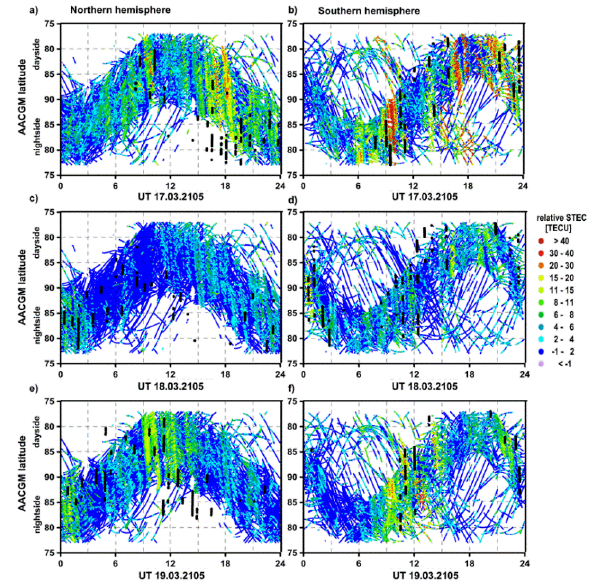
Figure 4. The comparison of patch detection using GNSS-based relative STEC values and SWARM in situ data (black dots). AACGM latitudes are derived with the projection of measurement points onto the noon – midnight axis of magnetic local time (MLT). Only the points with a density ratio higher than two are shown in the case of SWARM data.